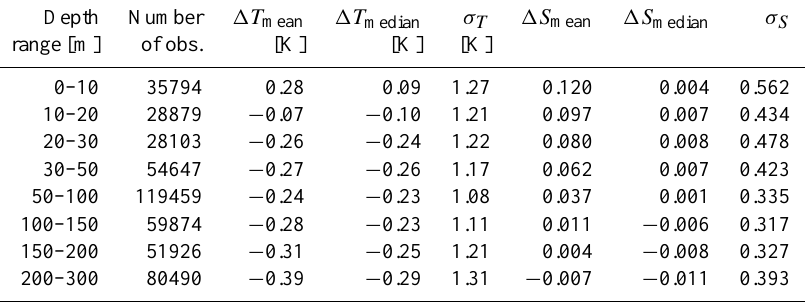
Table 1. Model temperature and salinity errors within Icelandic waters during the period 1992–2006 at the location and time of all available CTD profiles. Listed are the mean and the median model errors as well as the standard deviation σ of the mean error.